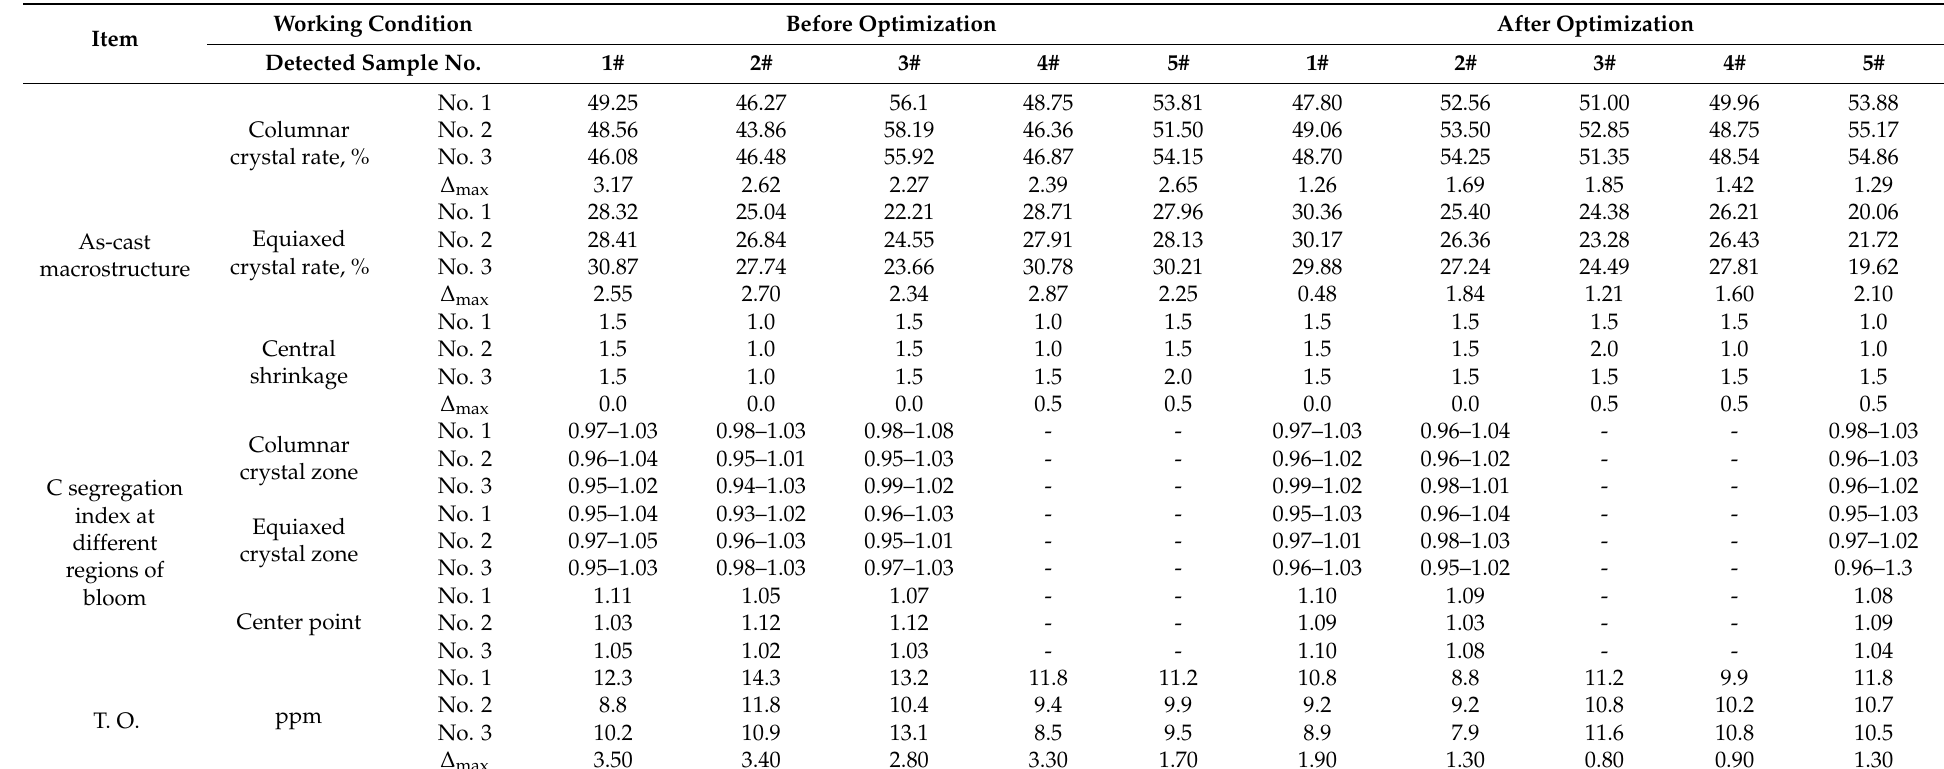
Table 9. Comparison of C70S6 bloom quality before and after tundish